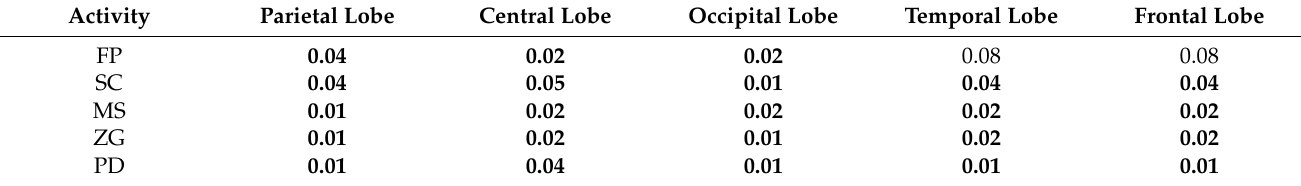
Table 10. Wilcoxon paired test: p -value results of beta band absolute power between the control test opened eyes (CE) and each of the games (Finger Painting (FP), Sorting Cubes (SC), More Switches (MS), Zero Gravity Switches (ZG), and Punch the Dummy